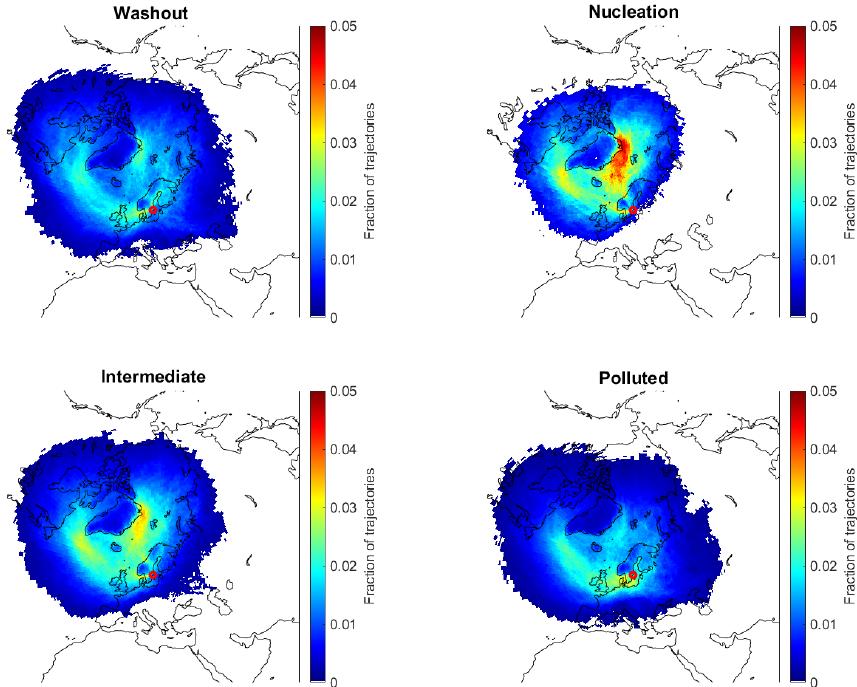
Figure 6. Dominant source regions of air mass trajectories belonging to cluster groups denoted washout (cluster 1), nucleation (clusters 2 through 6), intermediate (clusters 7 to 9) and polluted (clusters 10–12). Aspvreten shown by the red dot.